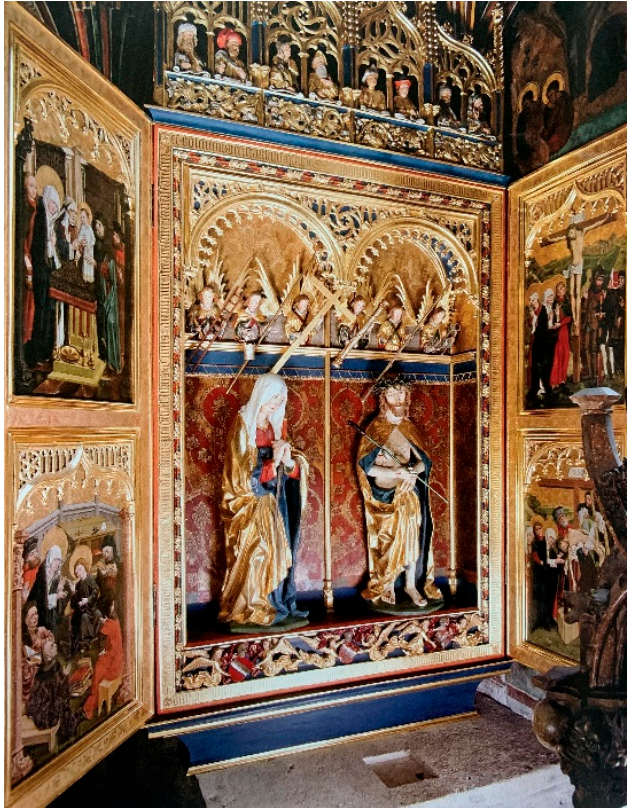
Figure 6. Triptych, wood and polychromy, ca. 1475, Cracow, cathedral, Chapel of the Holy Cross, photo published in [44] .